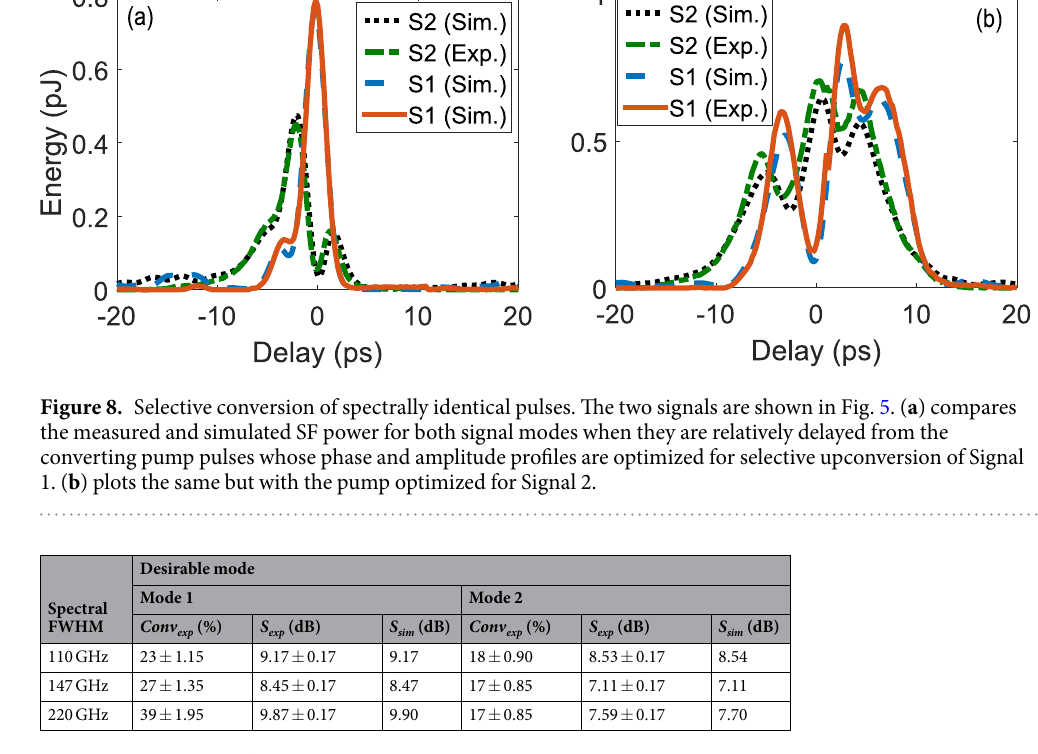
Table 1. Conversion efficiency and selectivity in low conversion regime. Measurement and simulation results for pulses 100% overlapping in spectral domain. Conv exp : Experimental Conversion Efficiency; S exp : Experimental Selectivity; S sim : Simulated Selectivity.